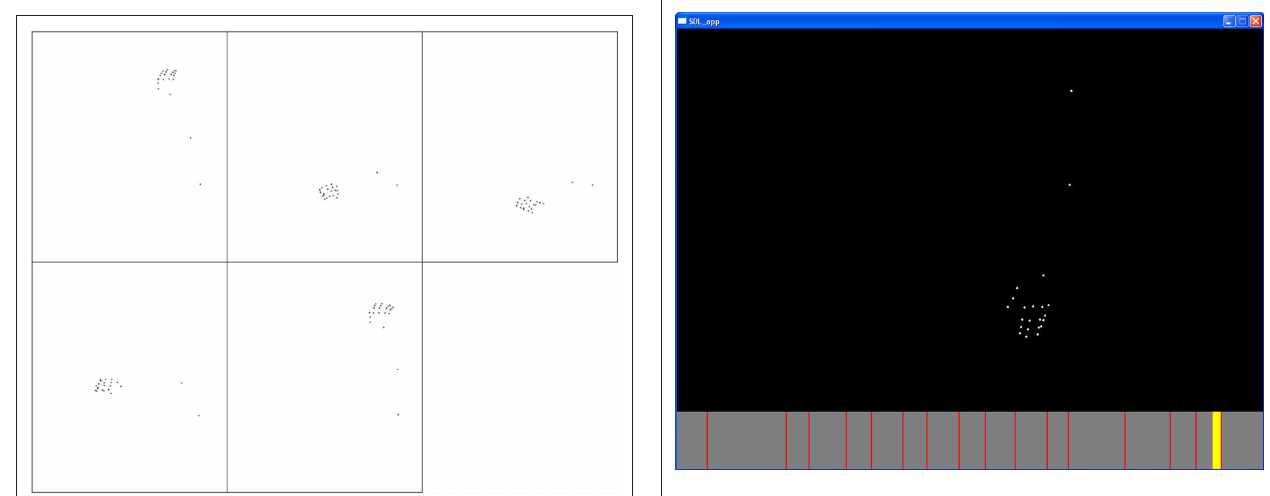
Figure 4 | Screen shot of an action (turning pages in a book) displayed in the stimulus player. The red lines are segmentation marks and the yellow bar is the